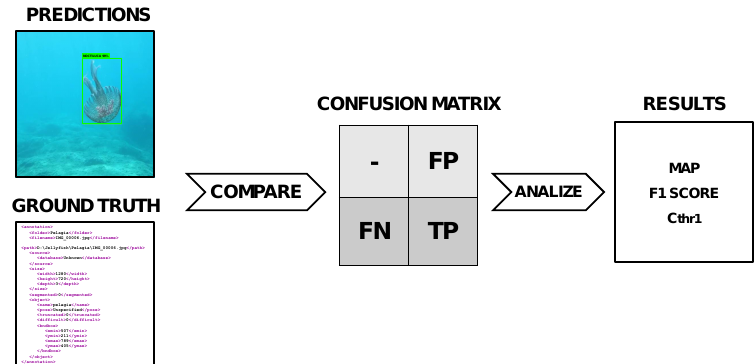
Figure 6. Model evaluation process. The final predictions are compared to their corresponding ground truth using the Intersection over Union (IoU) method and obtaining the False Positive (FP), False Negative (FN) and True Positive (TP) values. From these, the F1 score at the optimal threshold C thr 1 , altogether with the mean Average Precision (mAP) values are calculated.